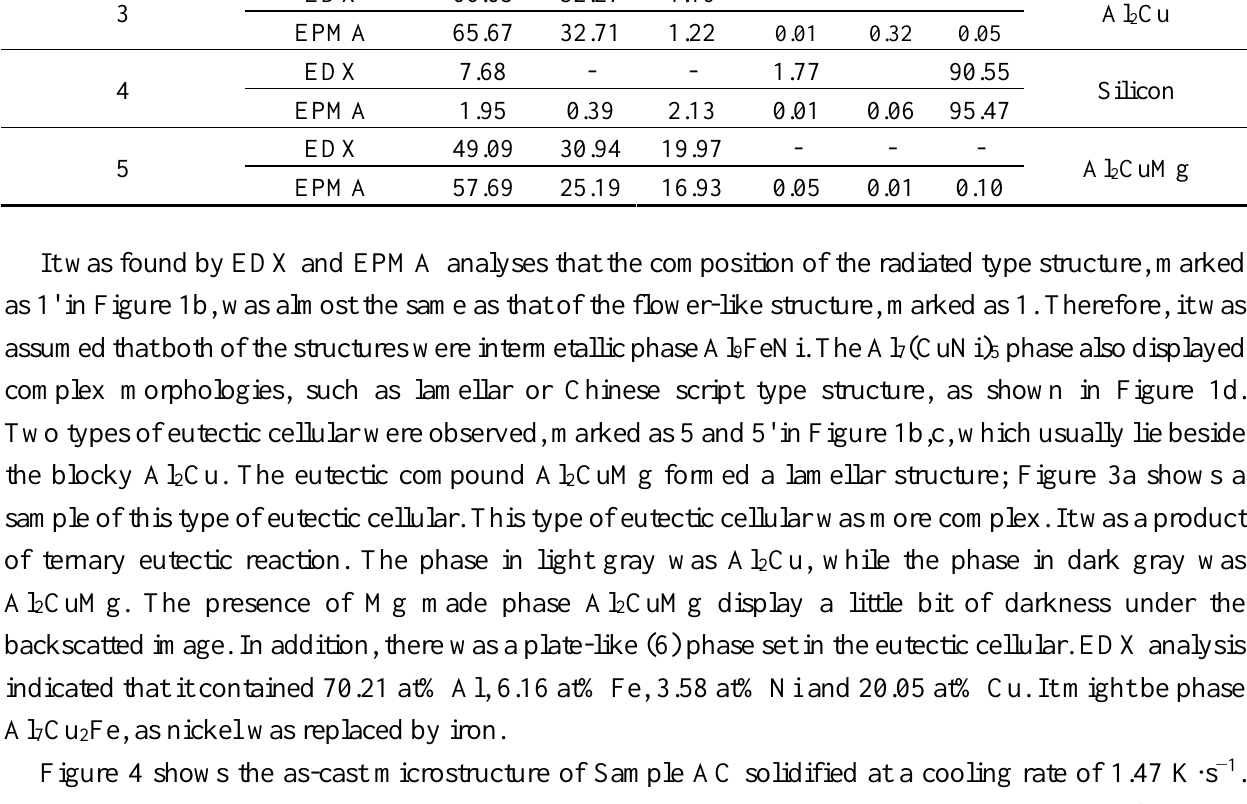
Table 2. Composition of intermetallic compounds in Sample FC measured by EDX and EPMA (at%). Phase # as marked in Figure 1